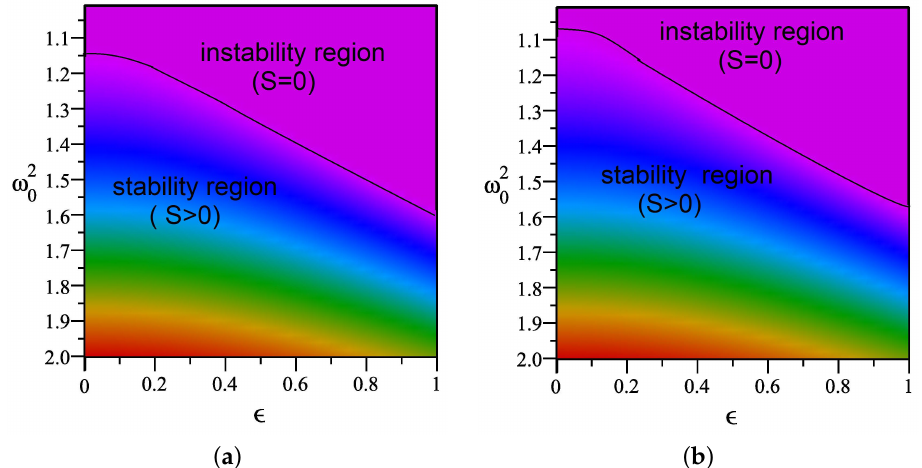
Figure 3. The stability diagram of Meissner system (20a) and (20b) with modulation (22) in the space ( (cid:101) , ω ) and for two values of the coupling parameter, ( a ) J 0 corresponds to the unstable region ( S = 0 ) , while the lower area corresponds to the stable region ( S > 0 )